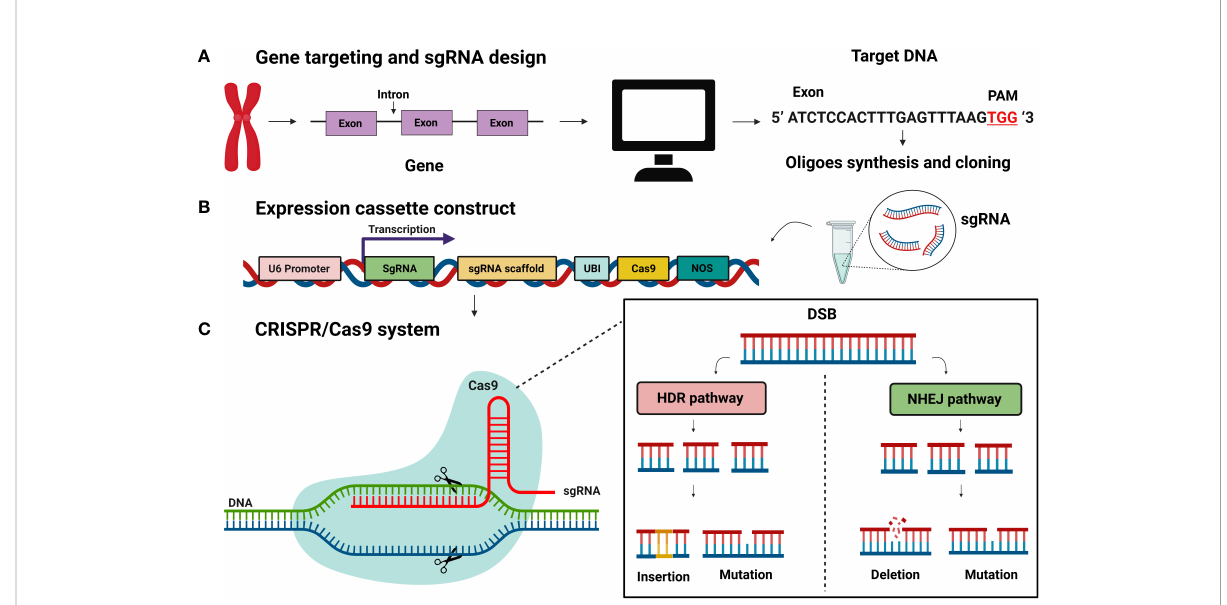
FIGURE 2 CRISPR/Cas9 system for genome editing. (A) Gene targeting and sgRNA construction. sgRNA expression constructs with 20bp target sequence (B) Expression construct for Cas9 and sgRNA (C) CRISPR/Cas9 system-based genome editing is DNA, DSBs (double-strand breaks) at target loci. DSBs induced genetic medication by two pathways: homology-directed mediated repair (HDR) and non-homologous end joining (NHEJ). The NHEJ process results in mutation and